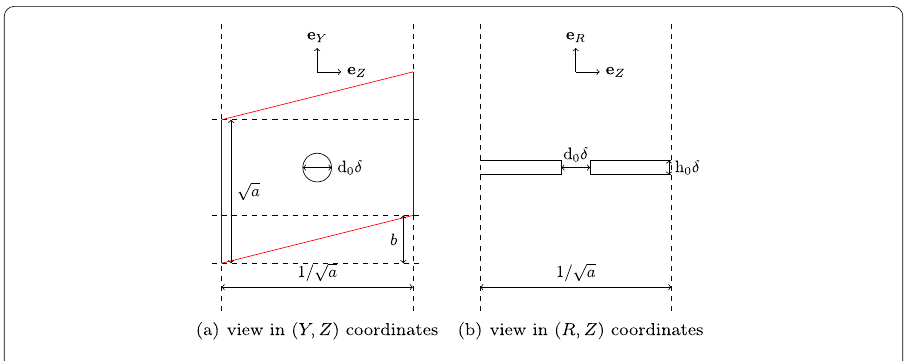
Figure 4 Representation of the periodicity cell B δ associated to the intermediate scale